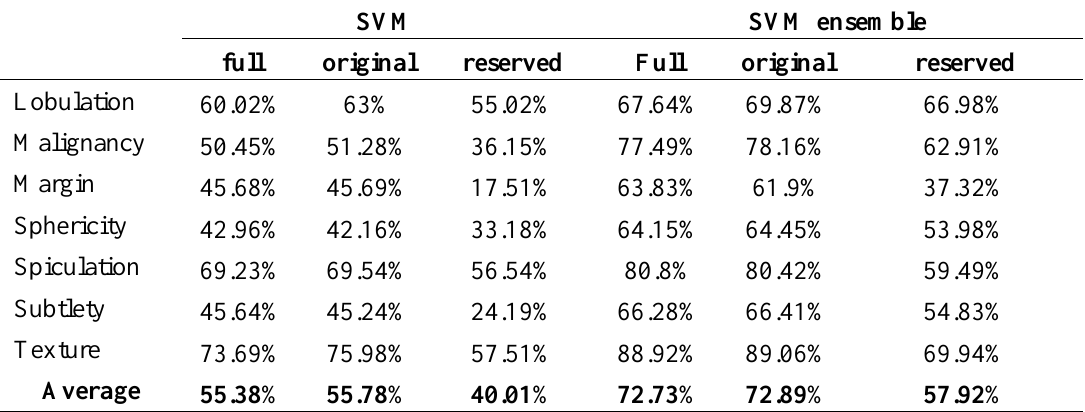
Table 11. Classification Accuracy of support vector machines on full, original and reserved data sets (single classifier vs. ensemble of